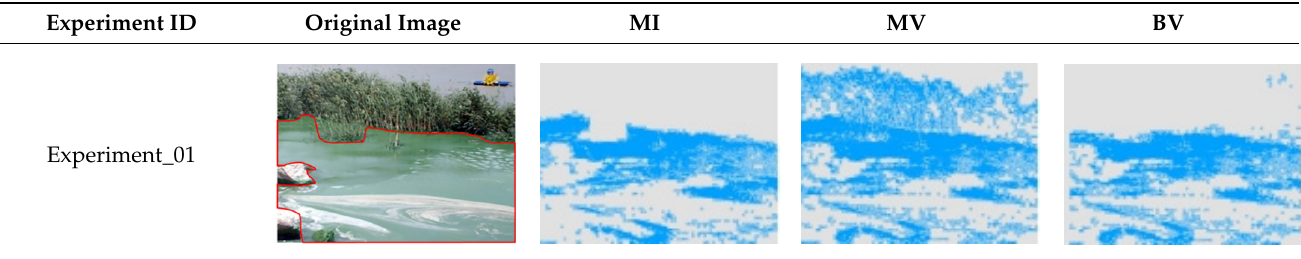
Table 1. Results of algal-bloom identification in algal-free areas. (Original image is the left video image; the area enclosed by the red line in the original image is the algae area; MI is the result of manual interpretation; MV is the recognition result using the method described in [31]; and BV is the recognition result using the proposed method).